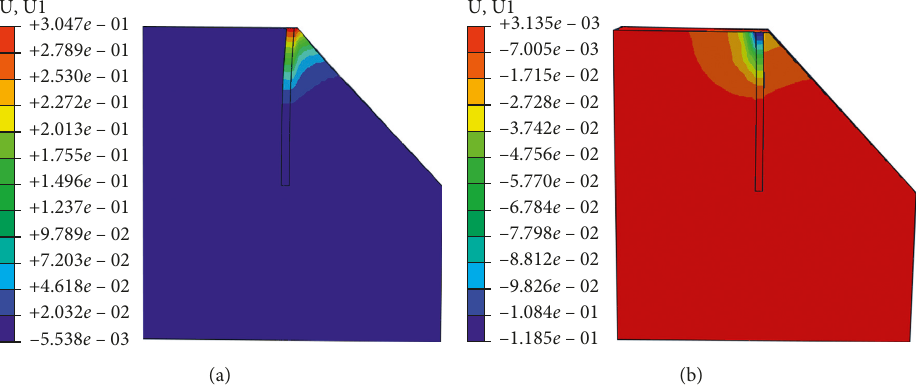
Figure 15: Lateral displacement field at H 0 (cid:31) 1000kN for the 1V :1H slope. (a) Toward loading. (b) Reverse loading.